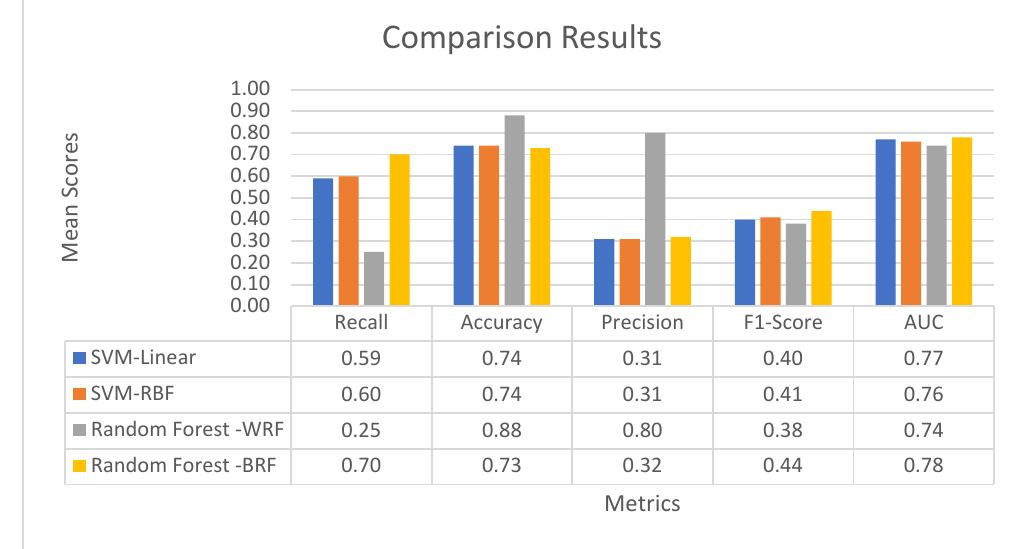
Figure 4. Aggregated results and comparison of proposed methodologies.